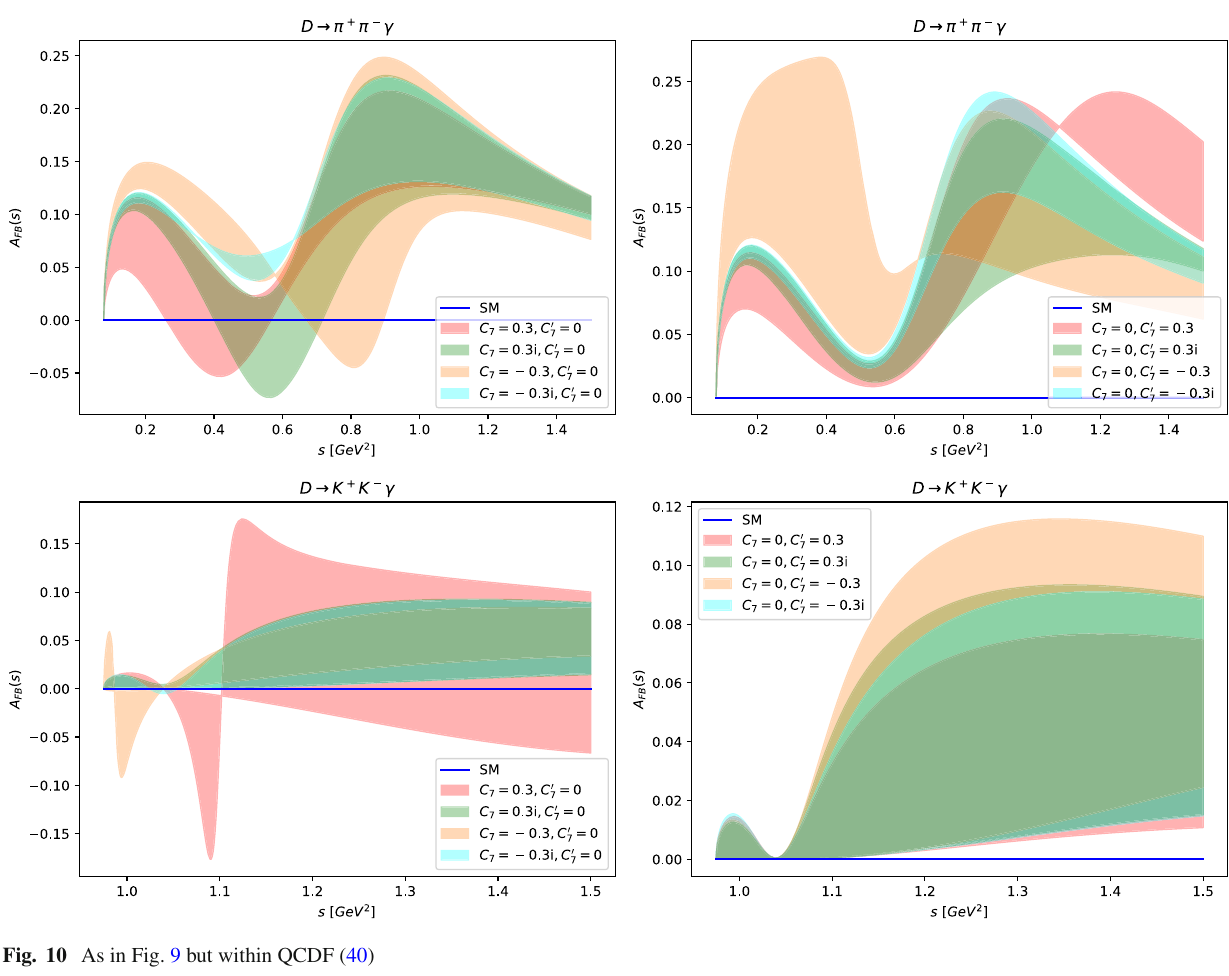
Fig. 10 As in Fig. 9 but within QCDF (40)